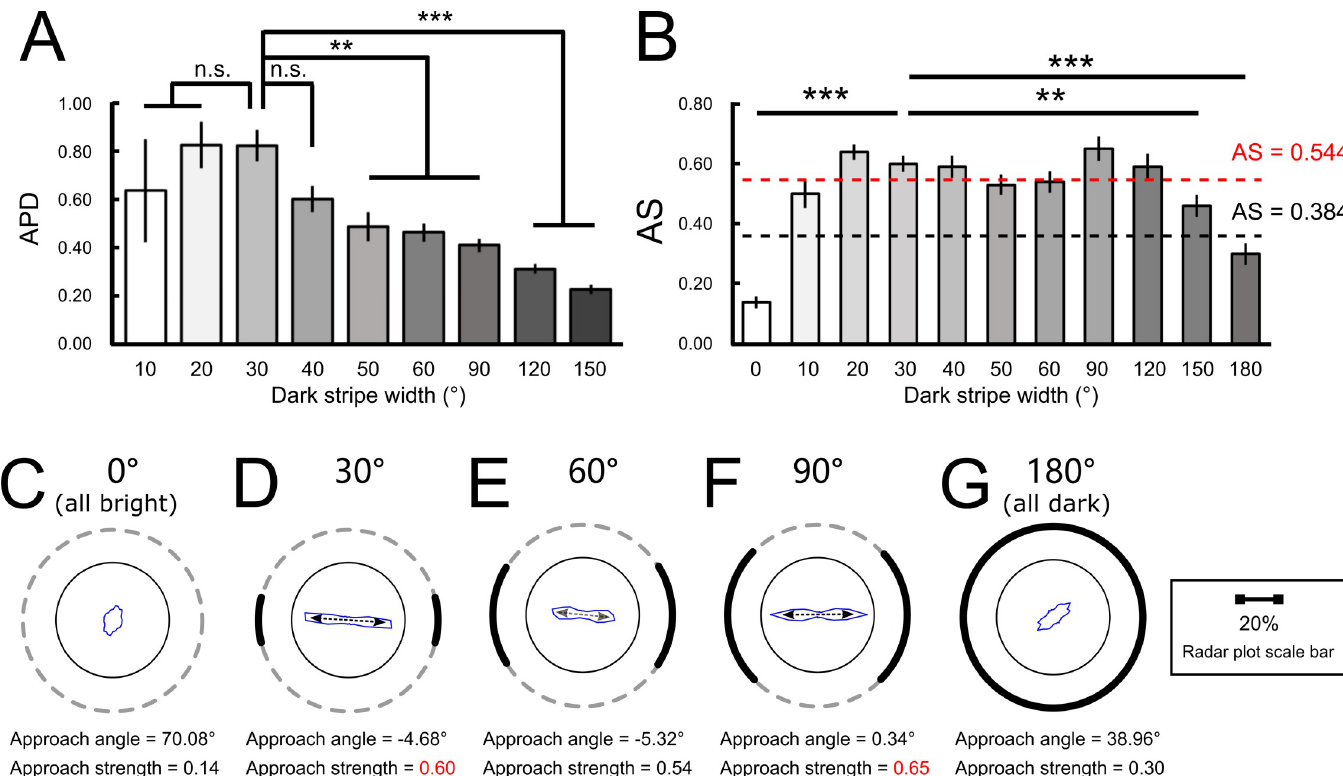
Fig 4. The population-averaged approach behavior for different stripe widths. (A) The mean population APD (approach probability density) indicates the difference between approach tendency on the dark region and the bright region, normalized by the angular span of each region. Positive APD indicates the tendency of dark stripe approach. While the stripe width of 20˚ or 30˚ gave rise to the largest APD , significant approach behavior ( APD > 0) can still be observed for all stripe widths. (B) The mean AS (approach strength), which indicates the strongest approach toward any direction regardless of the position of the stripes. AS that falls below the black dashed line is considered as no significant approach. AS that falls between the black and red dashed line is considered as significant but weak approach. AS that is above the red dashed line indicates strong approach. Again, all stripe widths gave rise to significant approach behavior. (C)-(F) The radar plots for the all-bright condition and three representative stripe widths (30˚, 60˚ and 120˚). The approach was all toward the center of the stripes regardless of the width of the dark stripe, as evident by the small approach angles.